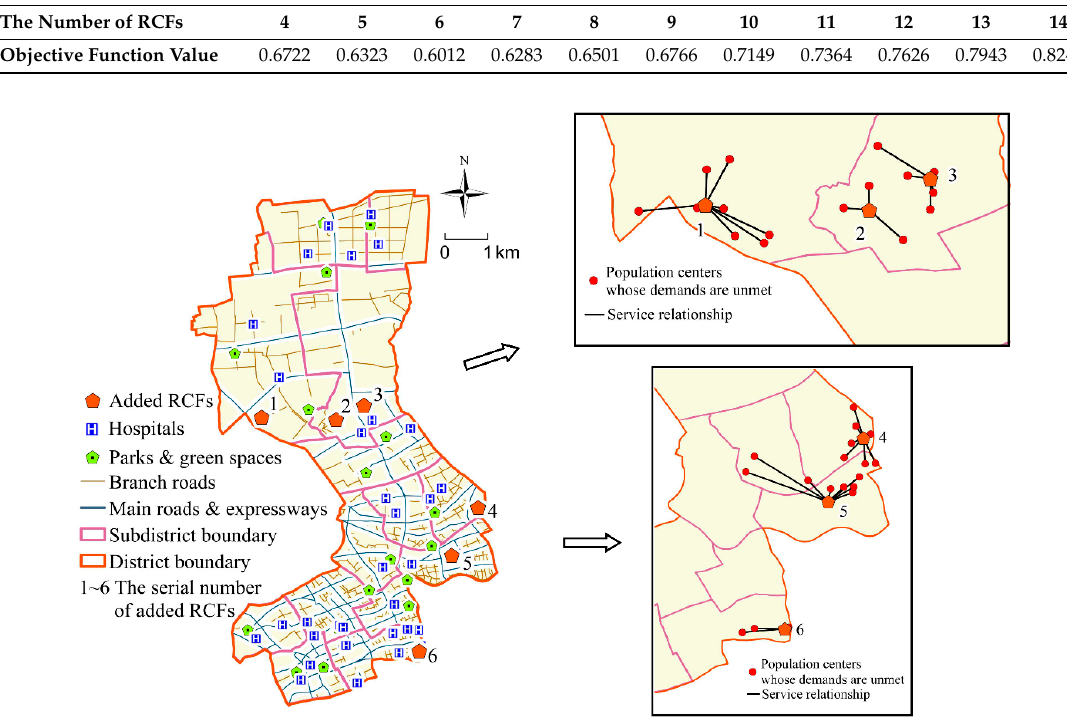
Table 2. The comparison of objective function values for different numbers of RCFs.